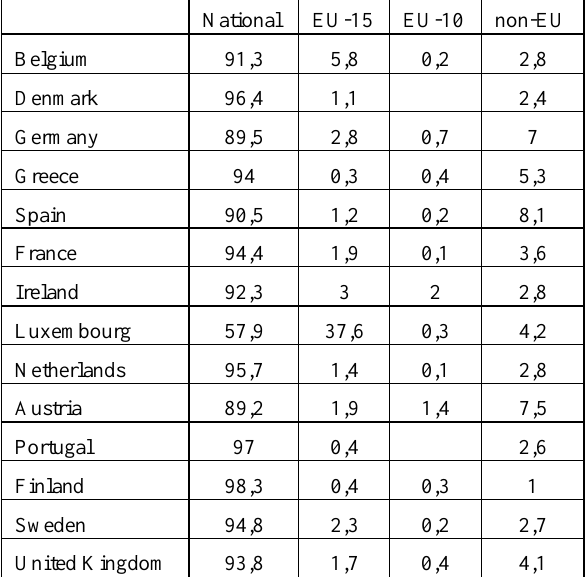
Table 9. Unemployment Rates 2003